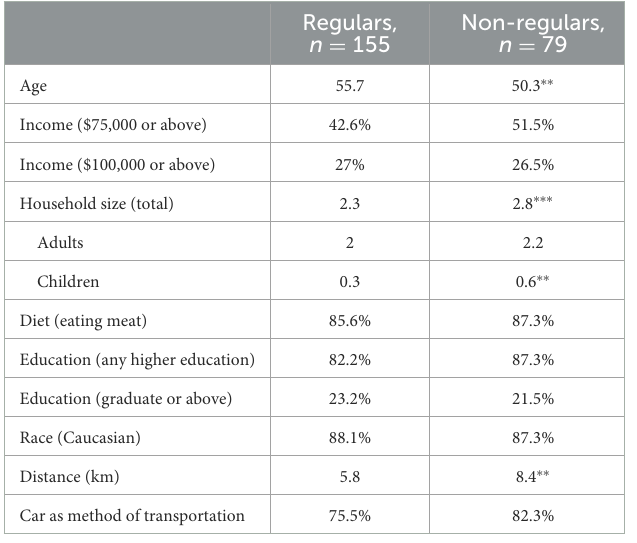
TABLE 6 Demographics of regular vs. non-regulars. TABLE 7 Attributes toward farmer’s markets for regulars vs.